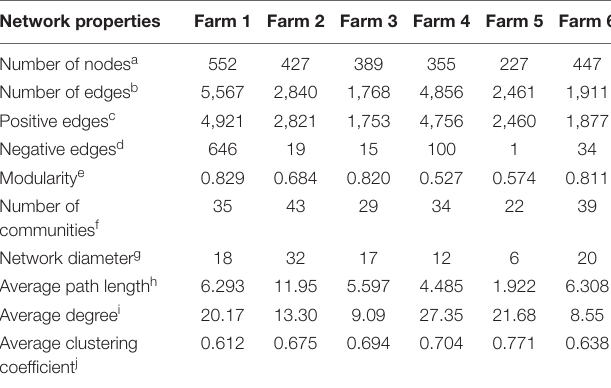
TABLE 3 | Topological properties of the networks as inferred by SparCC of I (semi-intensive) and T (traditional) beef production systems. Network